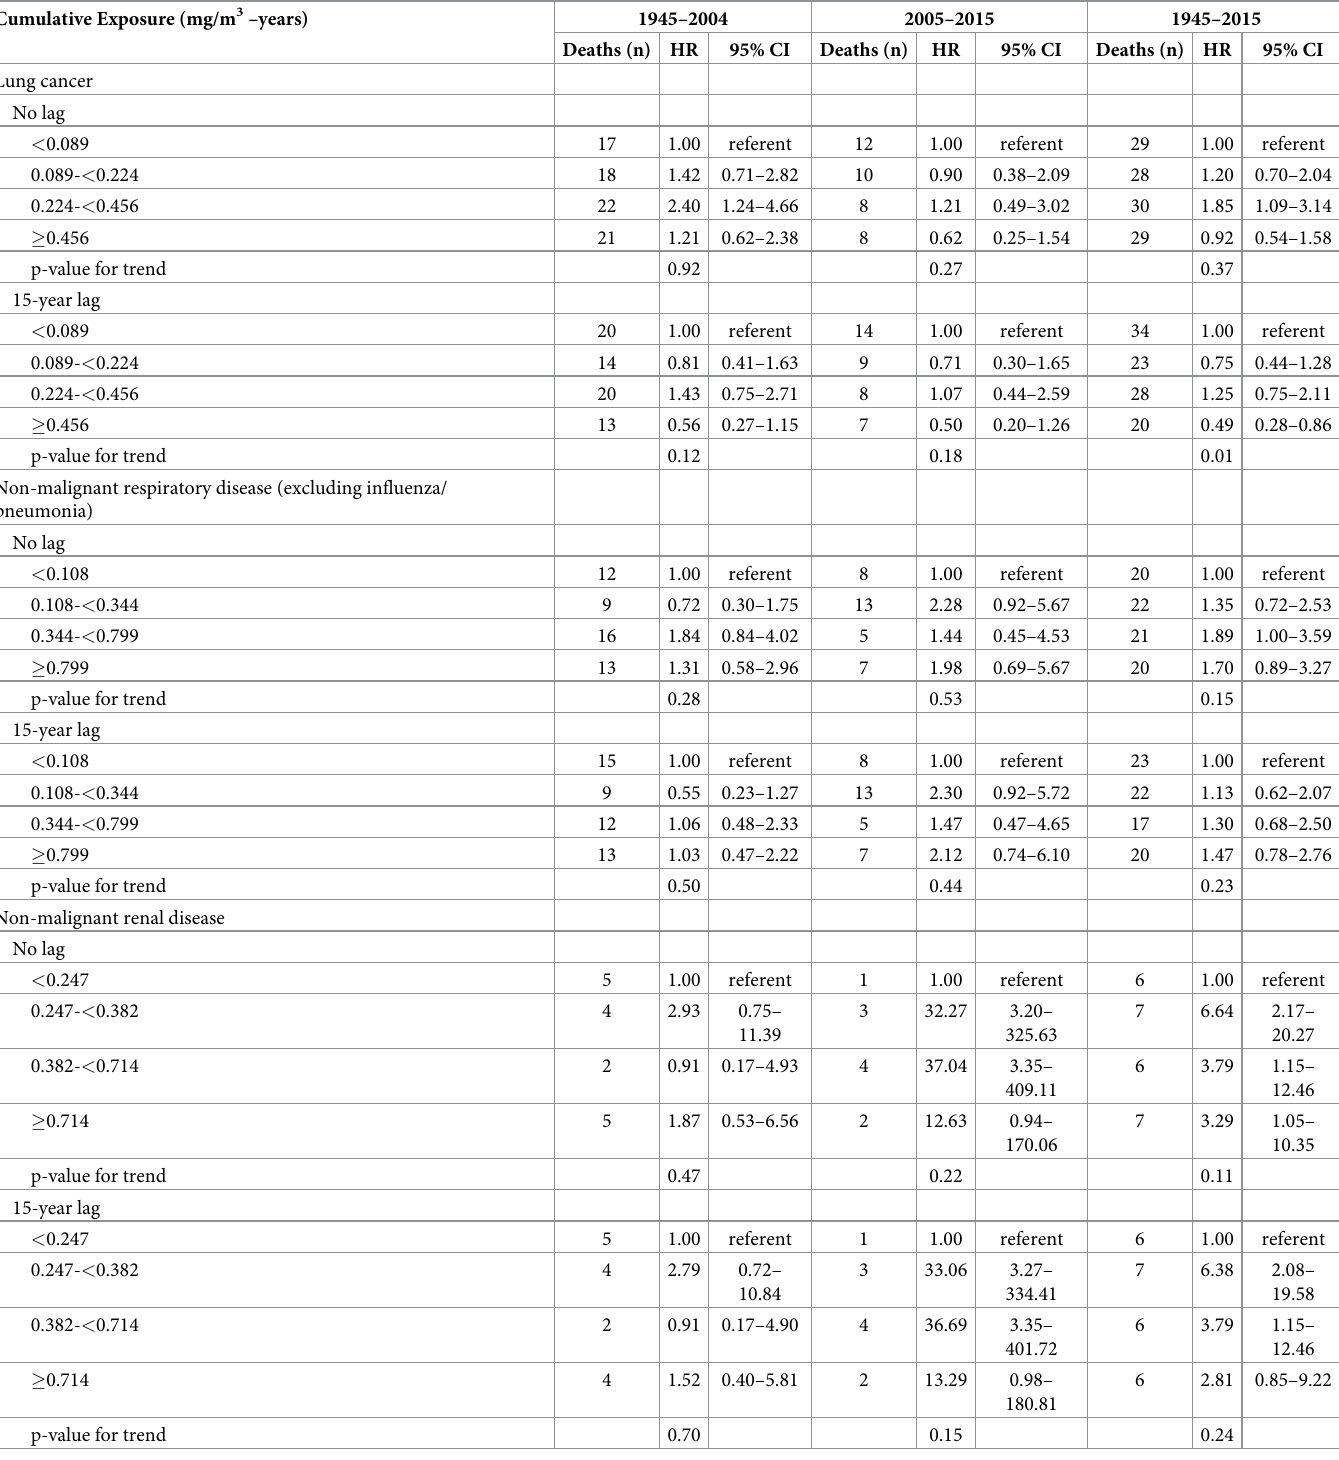
Table 2. Hazard Ratios (HRs) for selected causes of death by cumulative RCS exposure (mg/m3 –years) and follow-up period for the total